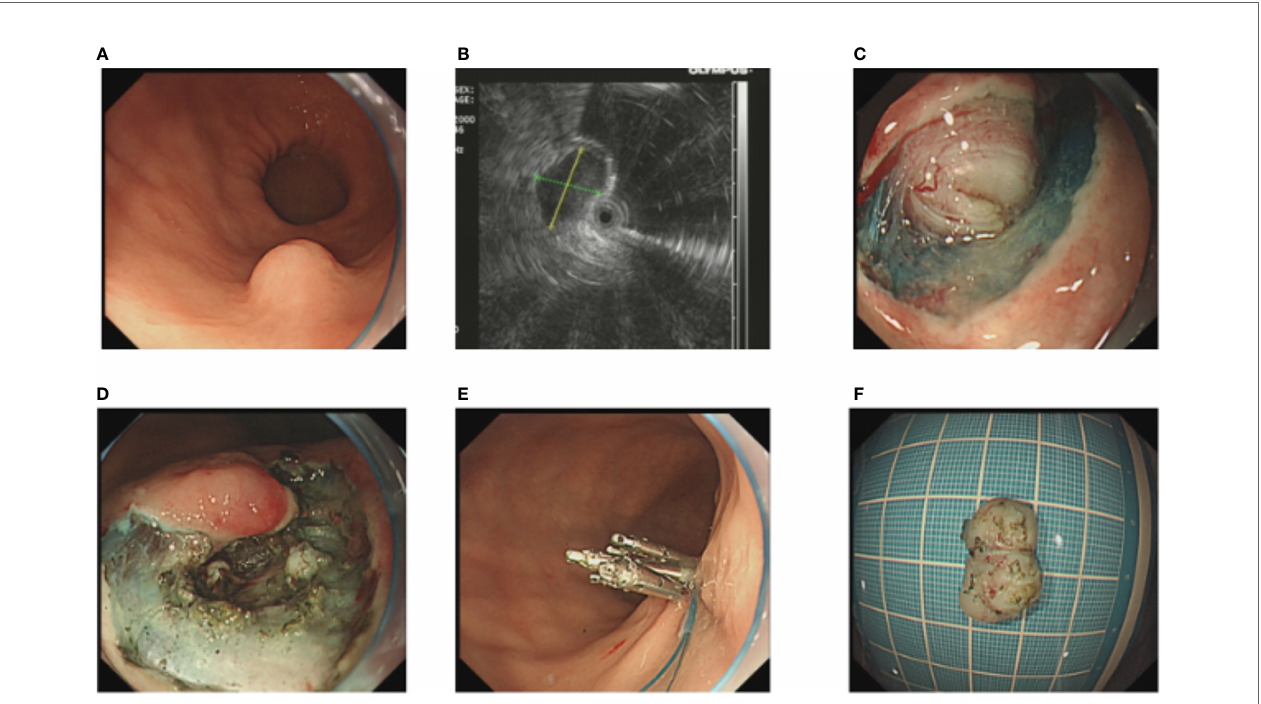
FIGURE 1 | The conventional endoscopic submucosal dissection of a gastric GIST. (A) A gastric GIST is observed. (B) The tumor originates from the muscularis propria layer on EUS. (C, D) After submucosal injection, endoscopic submucosal excavation of the tumor is performed using a Hook knife and the lesion is removed completely. (E) The gastric wall defect was managed by clips and a nylon rope. (F) View of the tumor after